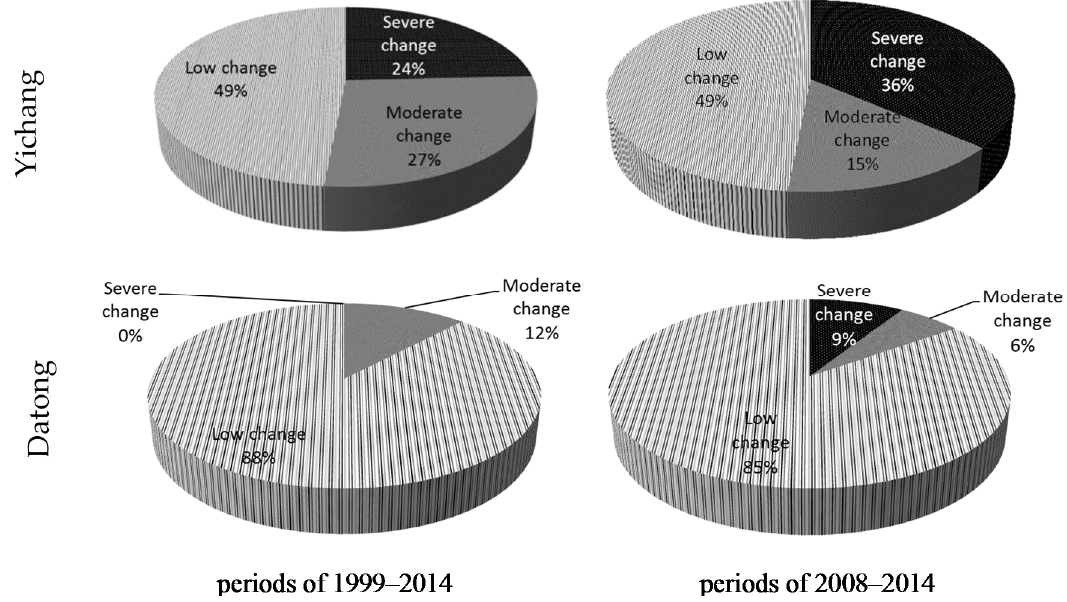
Figure 5. The IHA indicators change degree distribution during 1999–2014 and 2008–2014.